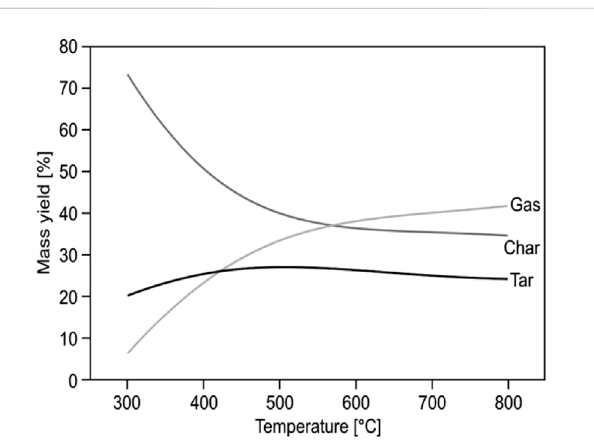
FIGURE 5 Reactor temperature ( ° C; RT) and mass yields (wt%, MY) correlation (Tezer et al.,